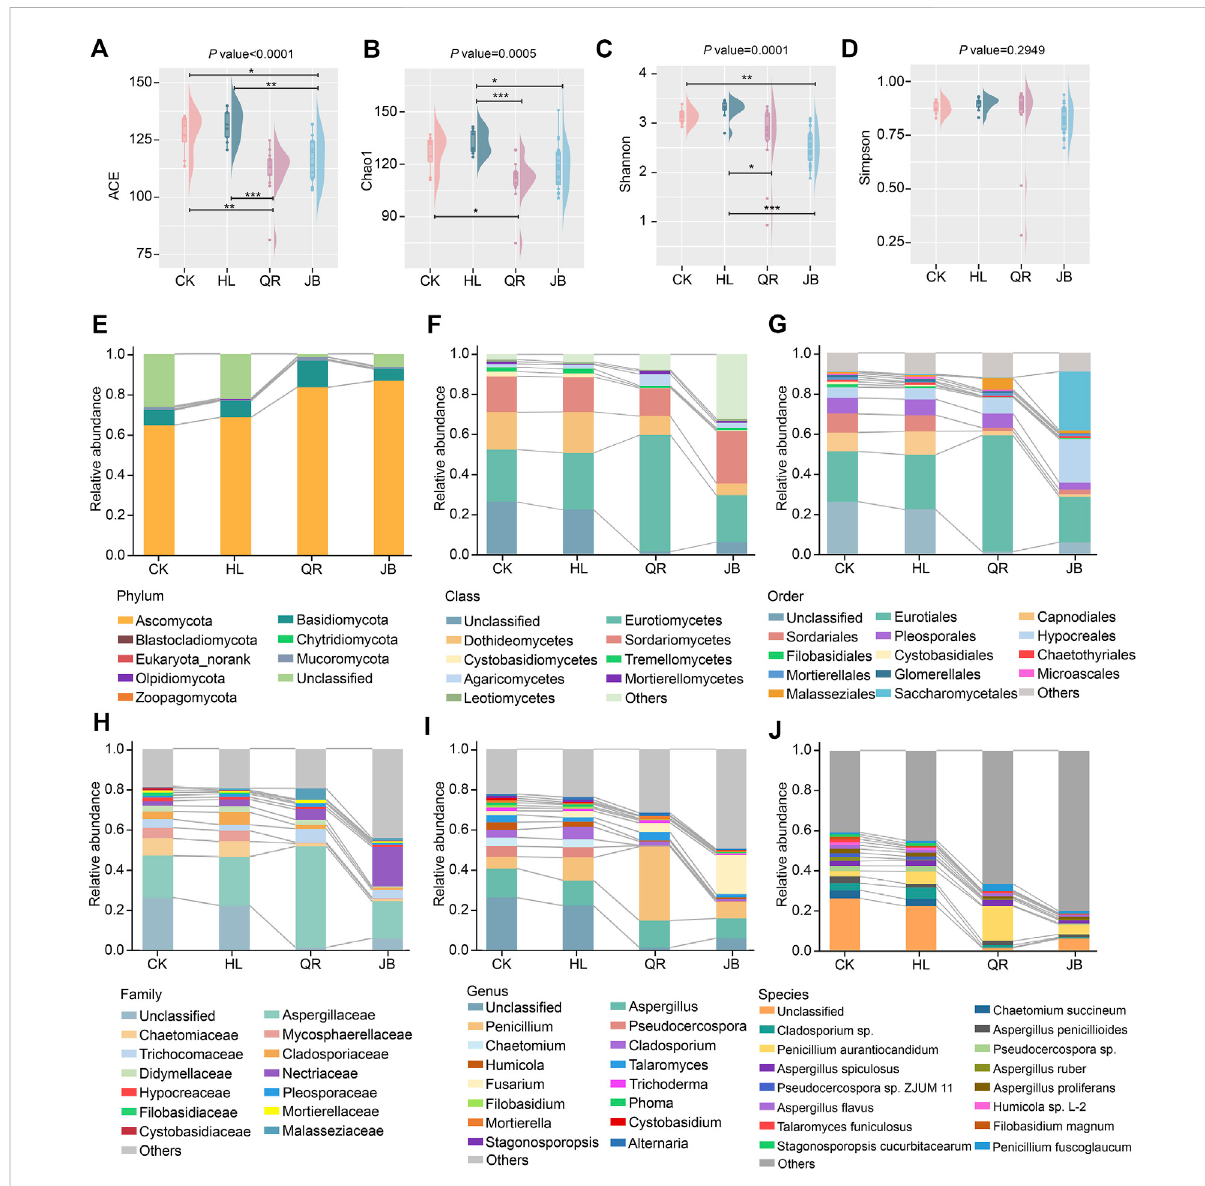
FIGURE 4 The alteration of gut fungal composition after antipyretic and diaphoretic drugs treatment. The alpha diversity of gut fungi among four groups assessed by (A) ACE (B) chao1, (C) shannon and (D) simpson indices. The gut fungal pro fi le diagram at (E) phylum (F) class, (G) order (H) family, (I) genus and (J) species level, respectively. * p < 0.05, ** p < 0.01, *** p <